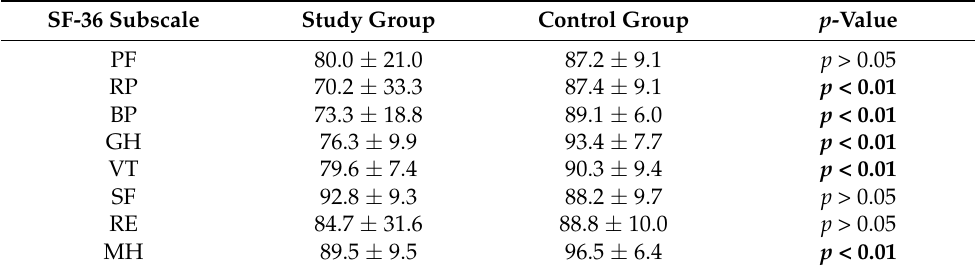
Table 1. Short-form 36 (SF-36) subscales in the two groups. In bold are the statistical significant differences. PF: physical functioning; RP: role-physical; BP: bodily pain; GH: general health; VT: vitality; SF: social functioning; RE: role-emotional; MH: mental